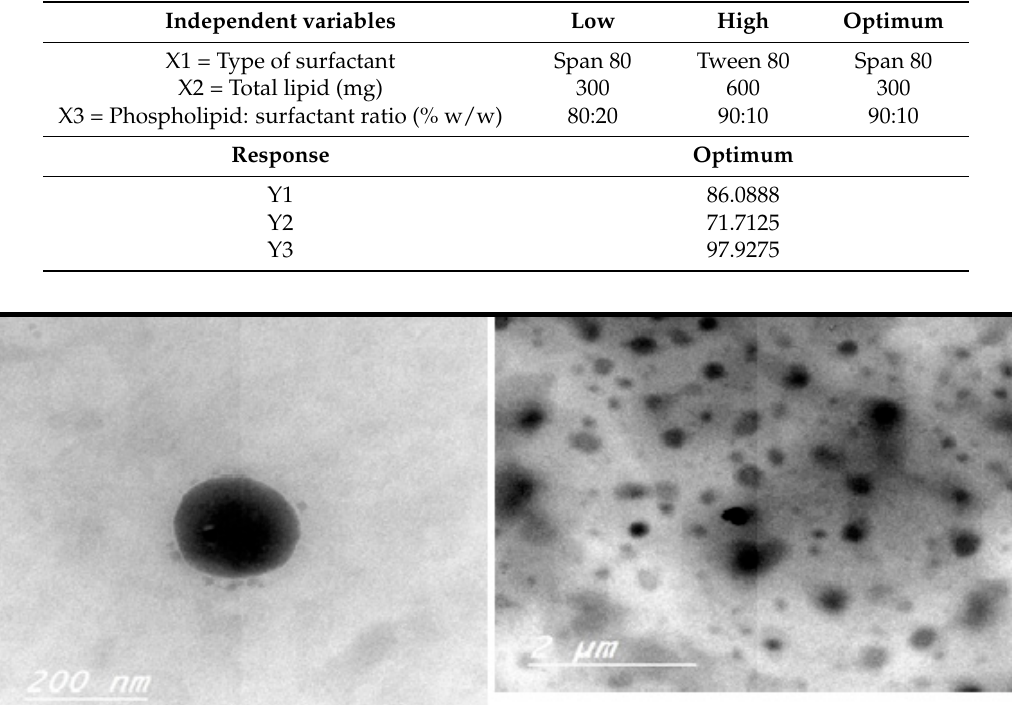
Figure 5. Transmission electron microscope image of the optimized MIC TRANSFEROSOME formulation (F5).